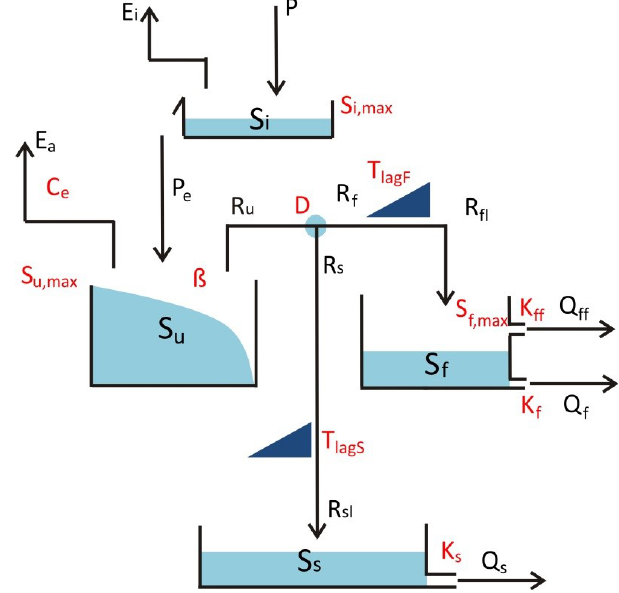
Figure 2. Model structure of the